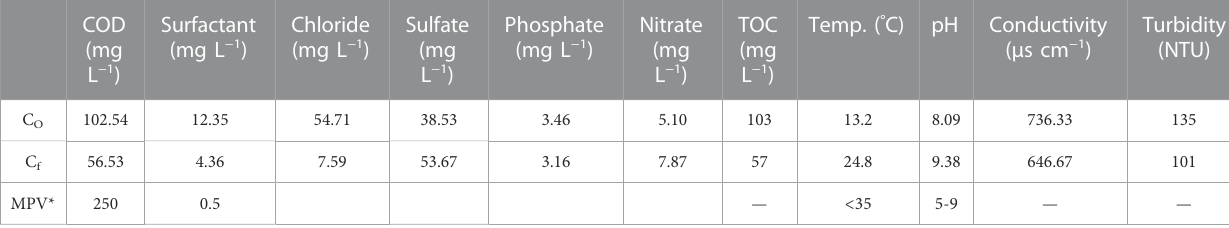
TABLE 1 Physicochemical characterization of domestic wastewater before and after electrochemical treatment. COD (mg L − 1